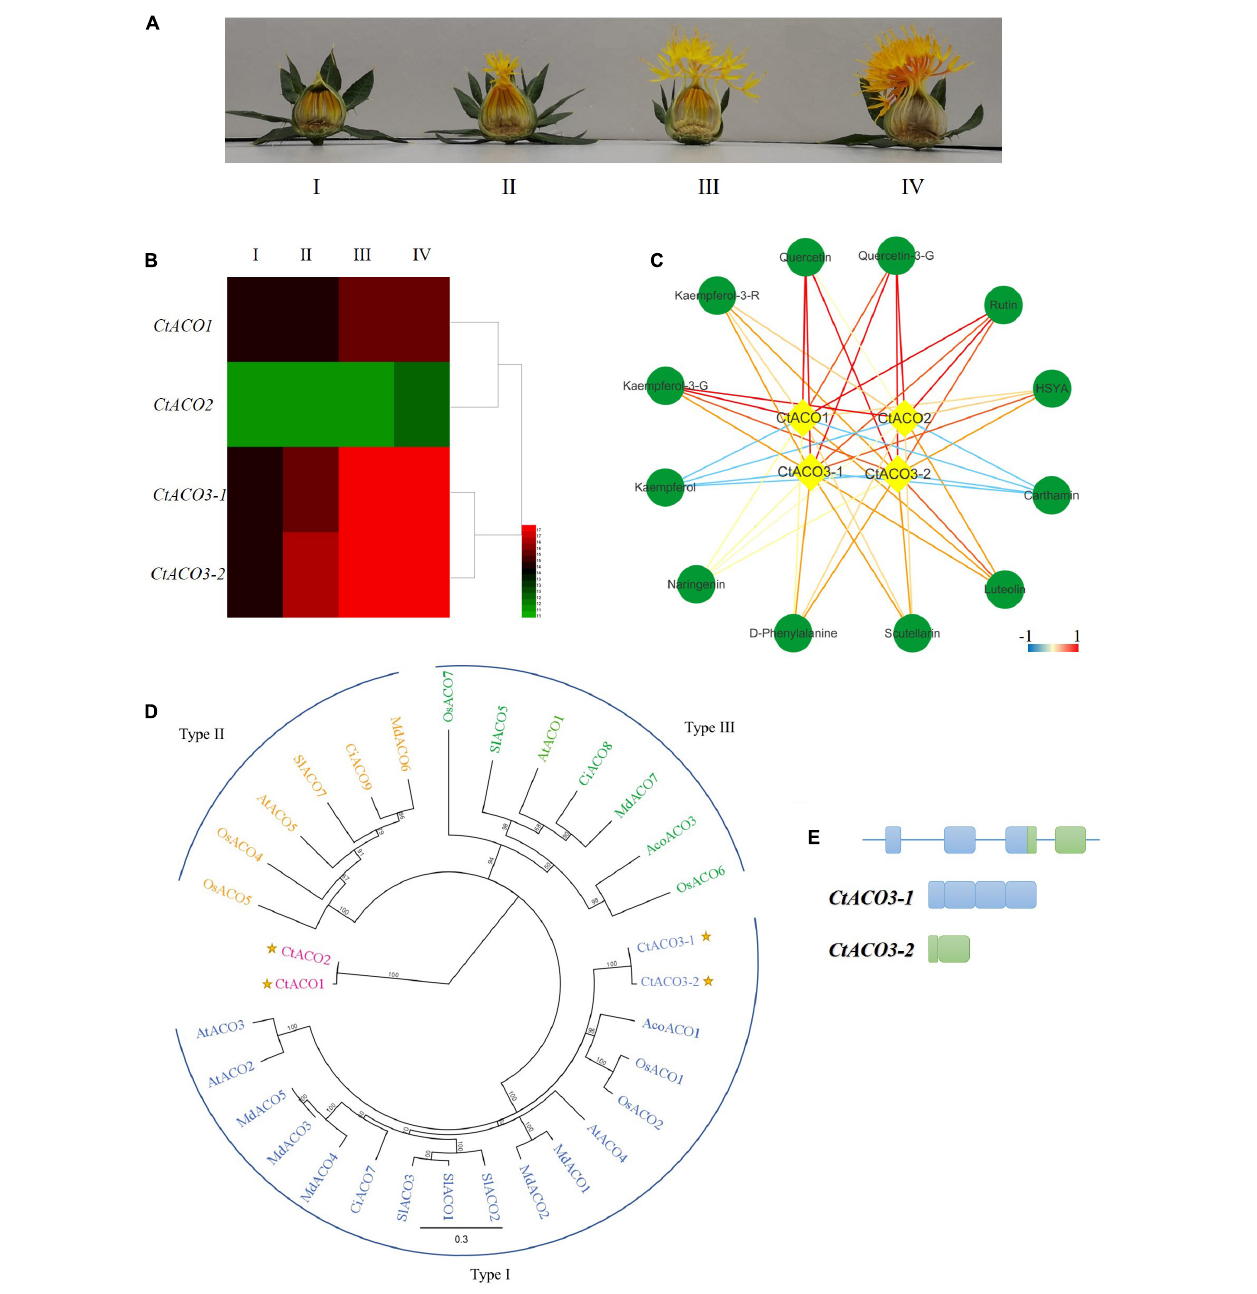
FIGURE 1 | The expression pattern of ACO genes in safflower. (A) Different developmental stages of safflower lines. I: the day before flowering, II: the first day of flowering, III: the second to third day of flowering, IV: the full bloom. (B) Four CtACOs expression patterns at different developmental stages of safflower lines, signal values by gene chip. (C) The correlation coefficients between CtACOs and flavone glycoside compounds. The color key was set from –1 to +1. kaempferol-3-G : kaempferol-3- O -glucoside, kaempferol-3-R: kaempferol-3-rutinoside, quercetin-3-G: quercetin-3- O -glucoside. (D) Maximal likelihood phylogenetic tree for ACO protein sequences of Carthamus tinctorius (Ct), Arabidopsis thaliana (At), Solanum lycopersicum (Sl), Malus domestica (Md), Oryza sativa (Os), Ananas comosus (Aco), and Citrus sinensis (Ci). Type I ACO is shown in blue, Type II ACO is shown in yellow, and Type III ACO is shown in green, Ct ACOs are plotted. (E) Schematic diagram of CtACO3 splice variants indicating introns and